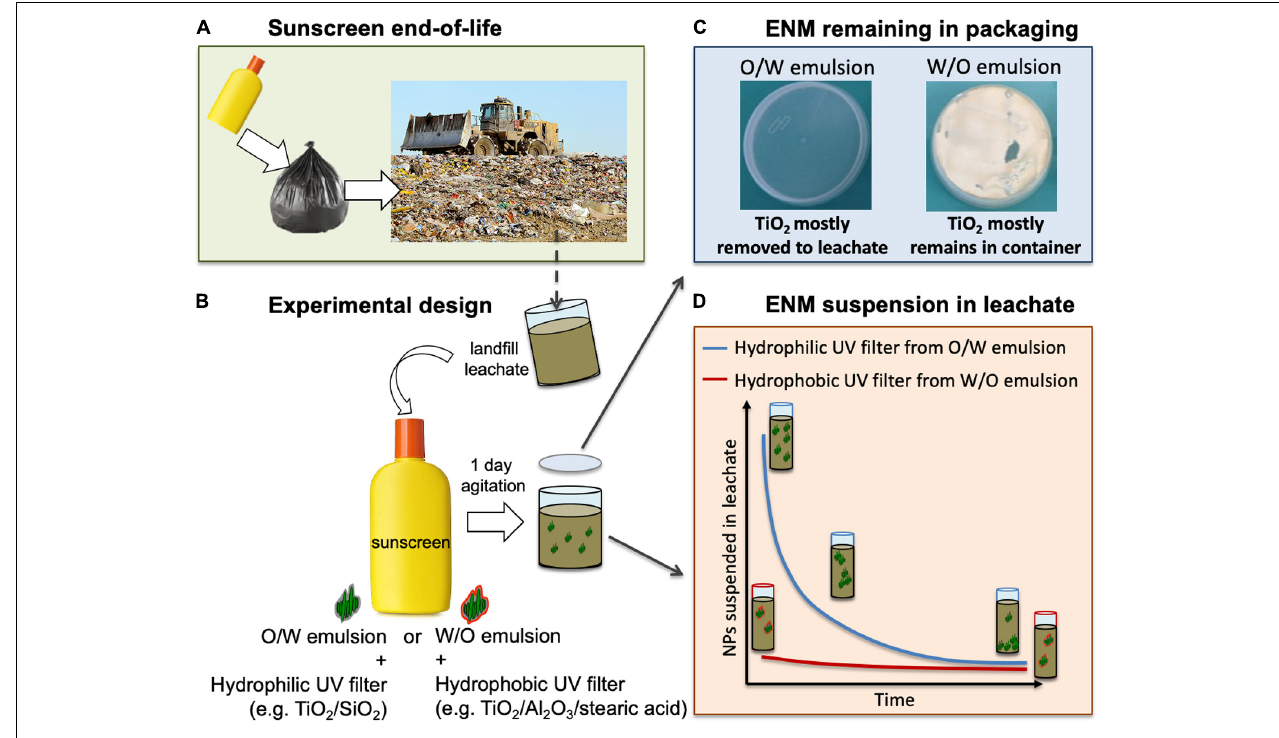
FIGURE 7 | Experimental approach proposed to mimic leaching in solid waste disposal at end of life (A) . A sunscreen product in packaging is agitated in a real landfill leachate over 1 day (B) . Then, the sunscreen remaining in the packaging is quantified (C) and the ENM suspended in the leachate are quantified over time (D)